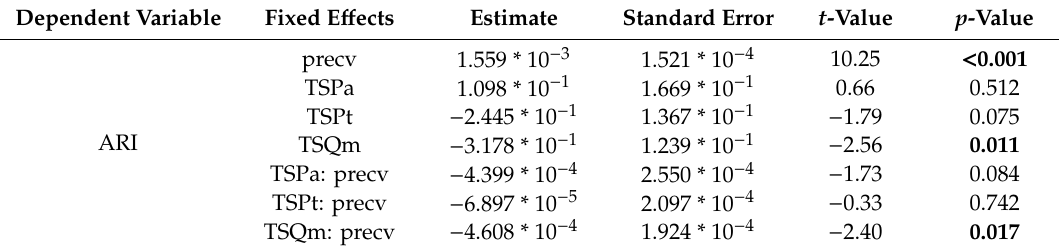
Figure 4. Graphical effect display for the interaction of precipitation during the vegetation period (precv) and tree species (TS). The vertical axis is labelled on the logarithm of annual radial increment (log (ARI)), and a 95-percent pointwise confidence interval is drawn around the estimated effect. Table 5. ANCOVA table of the linear mixed-effects models for the tree species P. asperata (TSPa), P. tabuliformis (TSPt) and Q. mongolica (TSQm) with ARI as the dependent variable and TS and precv as independent variables as well as their interaction, t -values and p -values for each fixed effect. p -values < 0.05 α -level are highlighted in bold type.